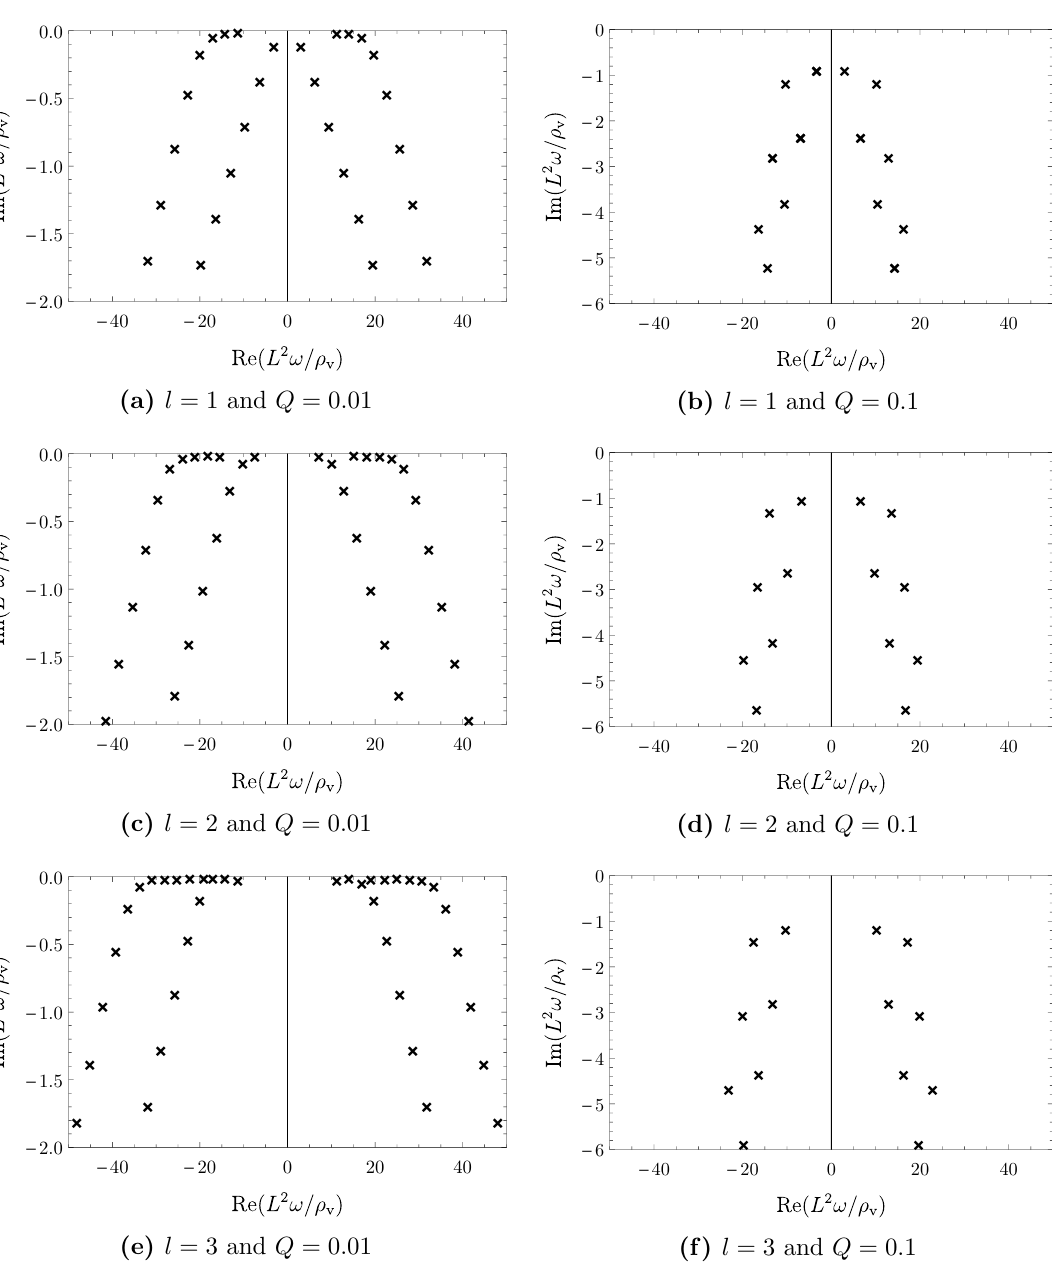
Figure 5. The complex frequency plane ! , in units of (cid:26) v =L 2 . The black crosses denote QNM frequencies of the (cid:13)uctuations (cid:26) l and A l when l = 1 (top row), l = 2 (middle row), and l = 3 t (bottom row), for Q = 0 : 01 (left column) and Q = 0 : 1 (right